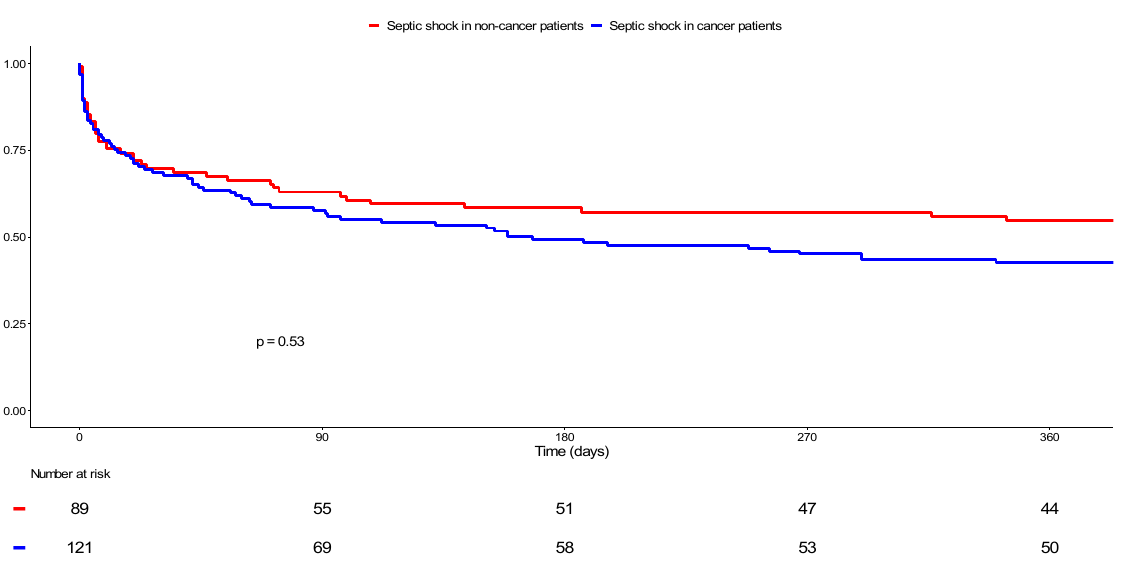
Figure 2. Comparison of survival between cancer and non-cancer patients with septic shock . Kaplan–Meier curves display the survival of non-cancer patients with septic shock (in red) and cancer patients with septic shock (in blue). The resulting p value for the log-rank test was 0.53.